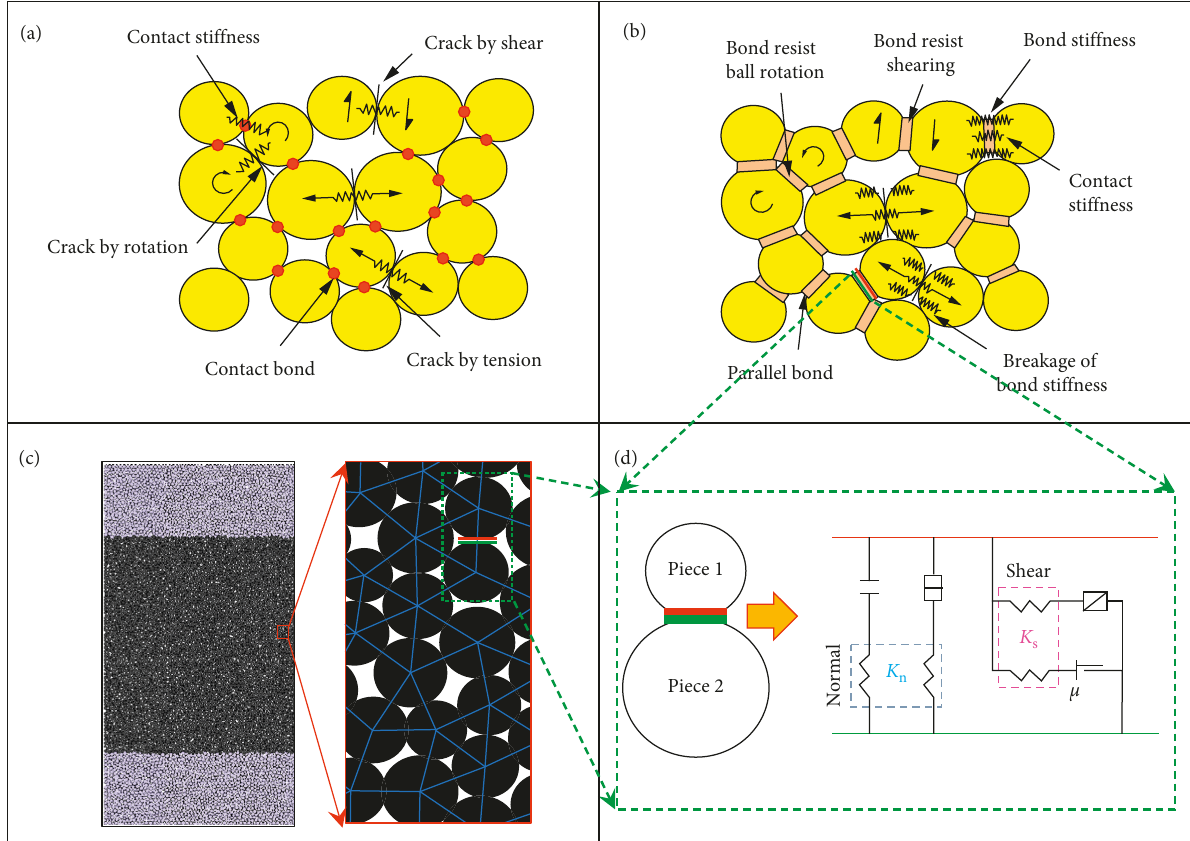
Figure 2: Illustration of bond models in PFC and numerical sample. (a) and (b) are contact-bond model (CBM) and parallel-bond model (PBM), respectively (modified from Cho et al. [30]). (c) A typical numerical RCR sample in this study. (d) Components of the linear parallel- bond model (modified from Itasca [28])), where K n , K s , and μ represent normal stiffness, shear stiffness, and friction coefficient at a contact point,